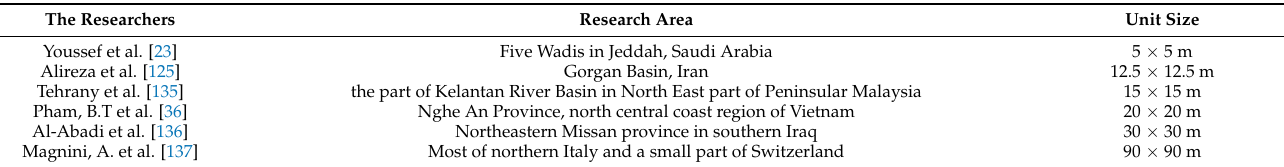
Table 8. Size of the assessment